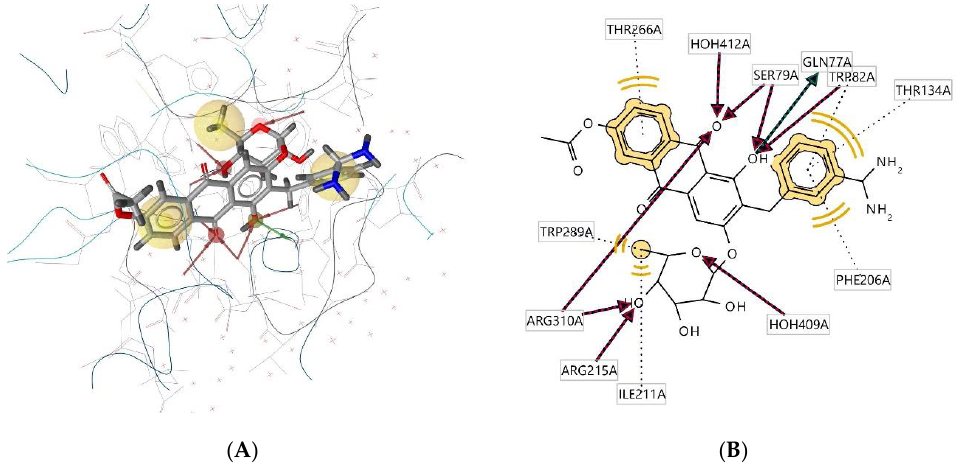
Figure 7. Ligand 302D interacts with the macromolecule. ( A ) 3D view of pharmacophore at the macromolecule binding site. ( B ) 2D view of pharmacophore. Pharmacophore features: hydrophobic interactions (H), yellow; hydrogen bond acceptor (HBA), red; hydrogen bond donor (HBD), green.